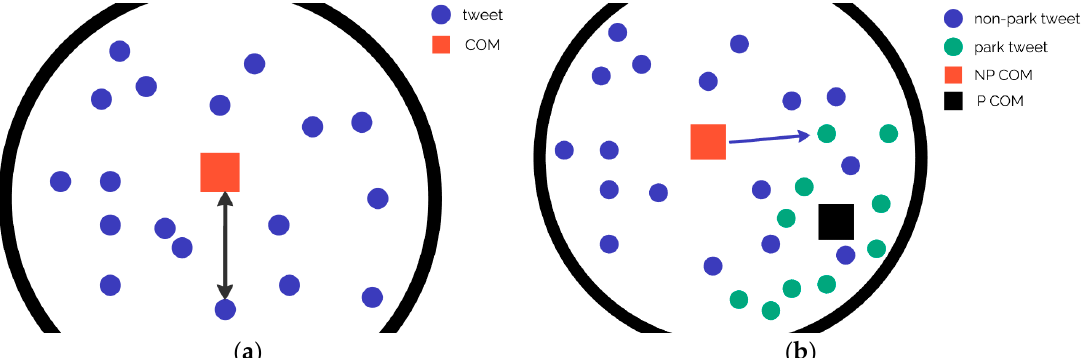
Figure 5. The illustration of how COM is interpreted ( a ) and how it is used to measure the average distance between COM and a park tweet ( b ).